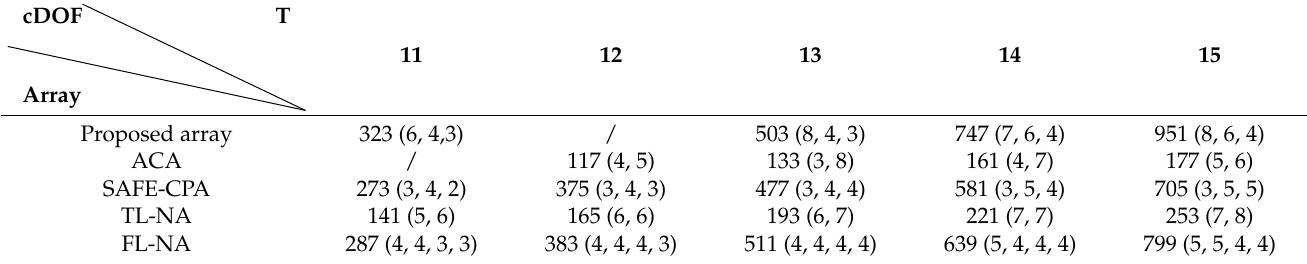
Table 5. cDOF examples of different array structures ( T = 11, · · · ,15).